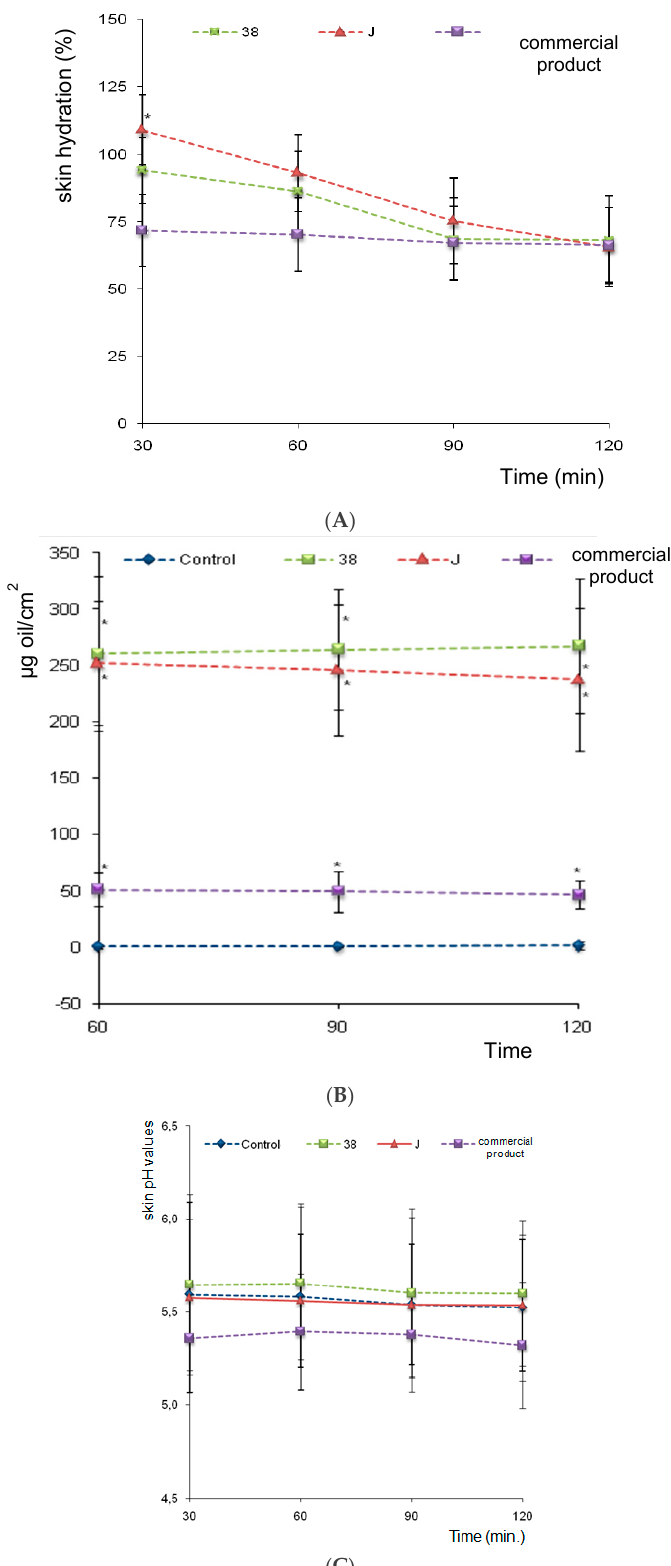
Figure 5. Hydration activity ( A ); skin oiliness ( B ); and skin pH evaluation ( C ) as a function of time. (*) no statistical differences between F38 and F38J. ( *) Significance level compared to the control group ( C ) ( p < 0.001).